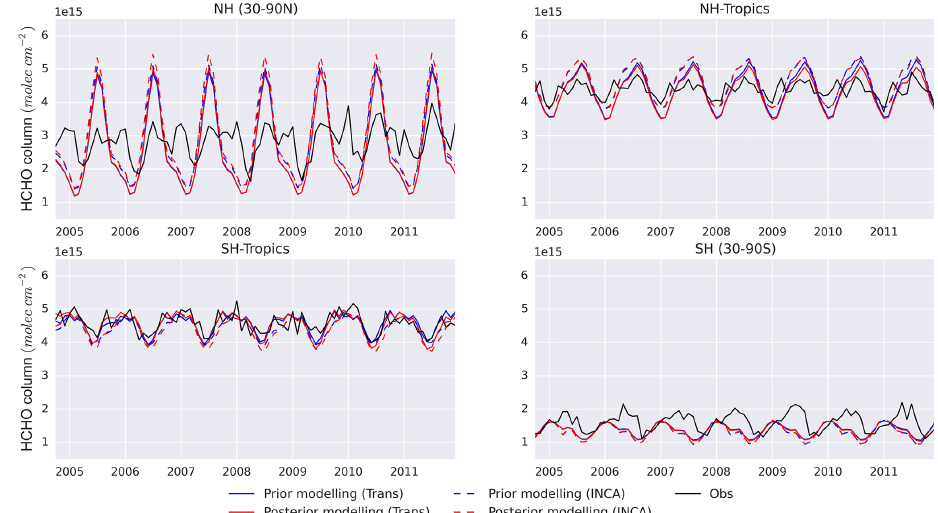
Figure 6. Time series of the CH 2 O total column averaged by latitudinal bands. The black lines indicate the CH 2 O total column from SAO OMI retrievals, green lines indicate prior simulations, and red lines indicate posterior simulations. Shading areas show the standard deviation within a latitudinal band. The forward and posterior simulations nearly overlay each